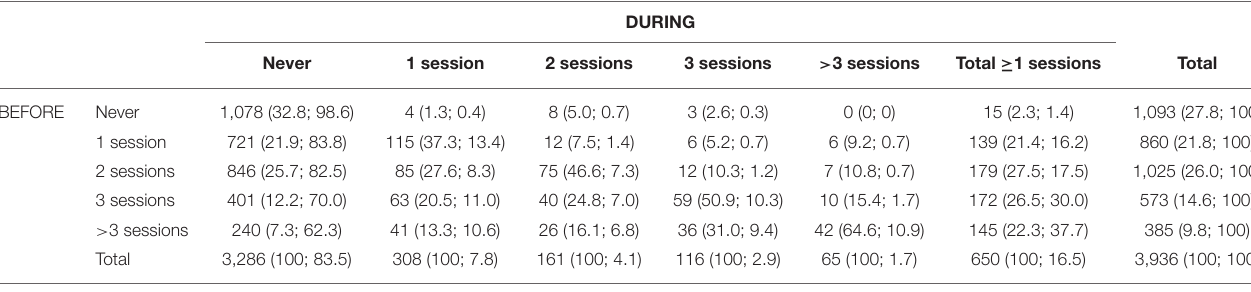
TABLE 3 | Contingency table for comparison of frequency (category percentages for during; category percentages for before) of participation in school extracurricular sports activities before and during lockdown.